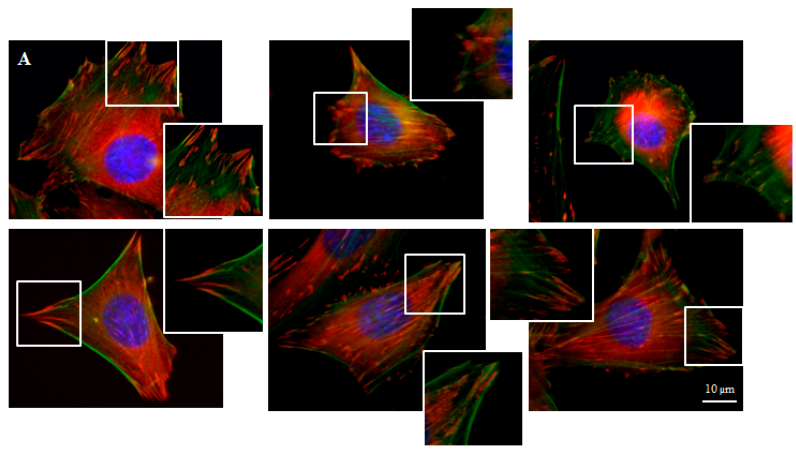
Figure 4. Spreading (cell area) of BALB/3T3 fibroblasts 12 and 24 h after seeding on glass and gra- phene platform. Data are represented as mean ± SD (standard deviation) of three independent experiments. Approximately 70 cells were evaluated in each experiment. Single cell-area was measured using ImageJ software. ** - statistically significant